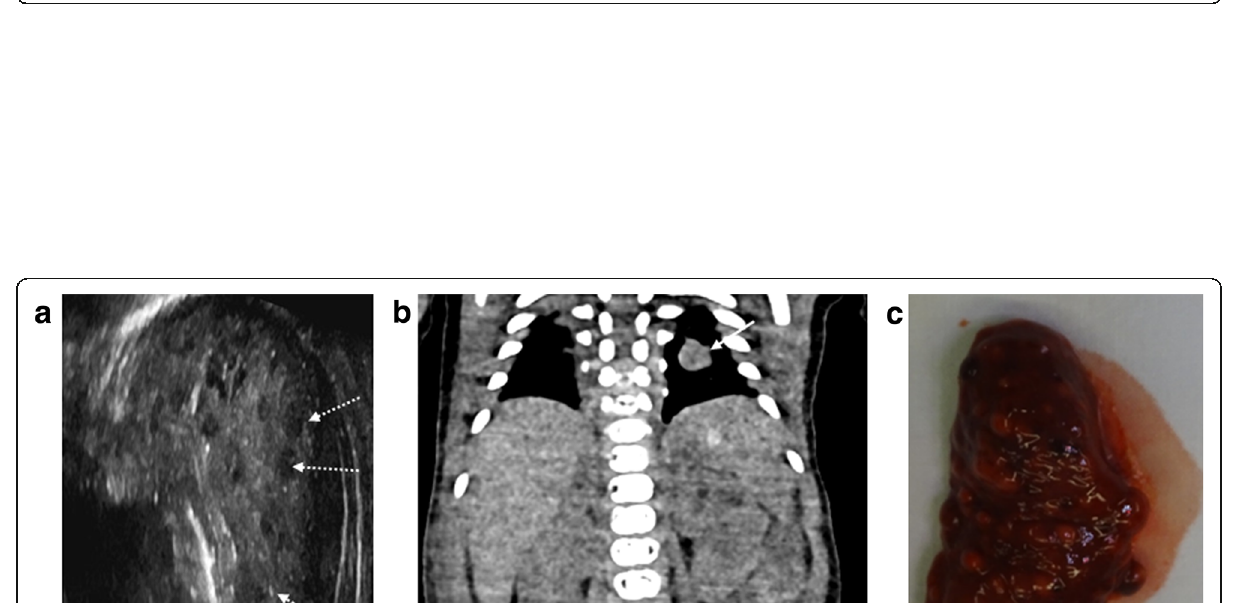
Fig. 13 Large exomphalos in a foetus at 22weeks gestation, following termination of pregnancy for multiple congenital anomalies. Post-mortem ultrasound performed 10days after delivery in both sagittal ( a ) and transverse plane ( c ) demonstrate herniation of bowel contents through the anterior abdomen. The contents of the exomphalos contained loops of bowel and the majority of the liver (dotted arrow). The external photographs of the foetus at autopsy ( b , d ) show the herniated contents being covered by a thin membrane with the umbilical cord arising from this (solid arrow). It is also possible to identify further anomalies of a neural tube defect (asterisk) and hypoplastic right limb (unfilled arrow) from the external images